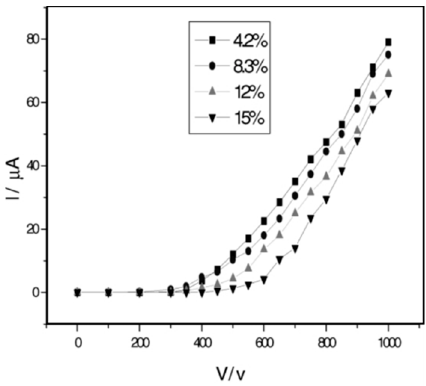
Figure 7. The graph showing the I–V characteristic of an FE cathode made of dried CNT suspensions for different constitutes of CNTs (reprinted with permission from [104]).